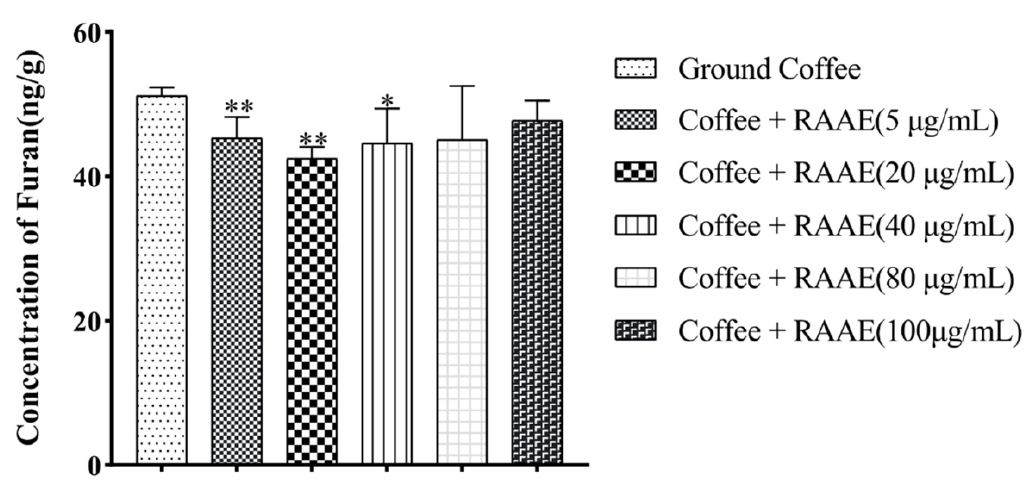
Figure 4. The reduction effect of different concentrations of ‘XJ3 ′ RAAE on the furan content in coffee. * means p < 0.05, and ** means p < 0.01.